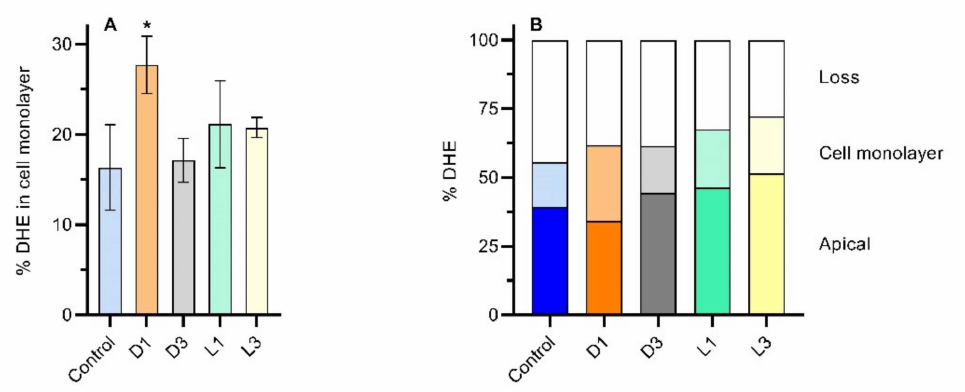
Figure 5. Quantification of DHE at the end of the permeability assays (6 h) for an initial concentration of DHE in the apical compartment equal to 10 µ M. The amount of DHE extracted from the cell monolayer is shown in plot ( A ), and the distribution of DHE in the different compartments is shown in plot ( B ). The bars in dark colors represent DHE in the apical compartment, and those in light colors DHE extracted from the cell monolayer. Statistically significant differences from the control are indicated by * ( p < 0.05, n =